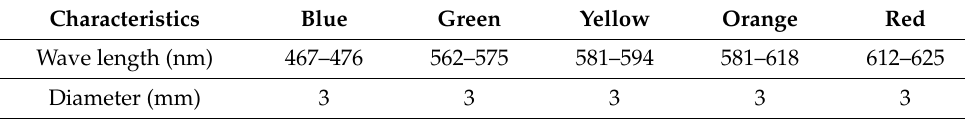
Table 2. Characteristics of the LEDs of the prototype employed in these tests.